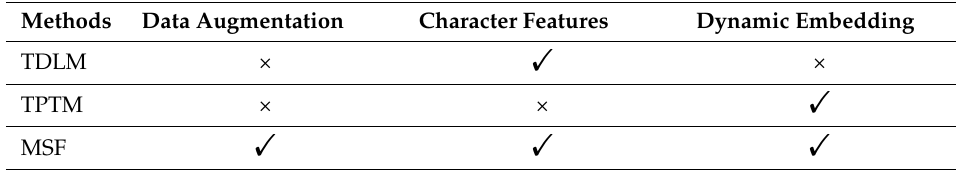
Table 1. Comparison of offensive speech-detection methods